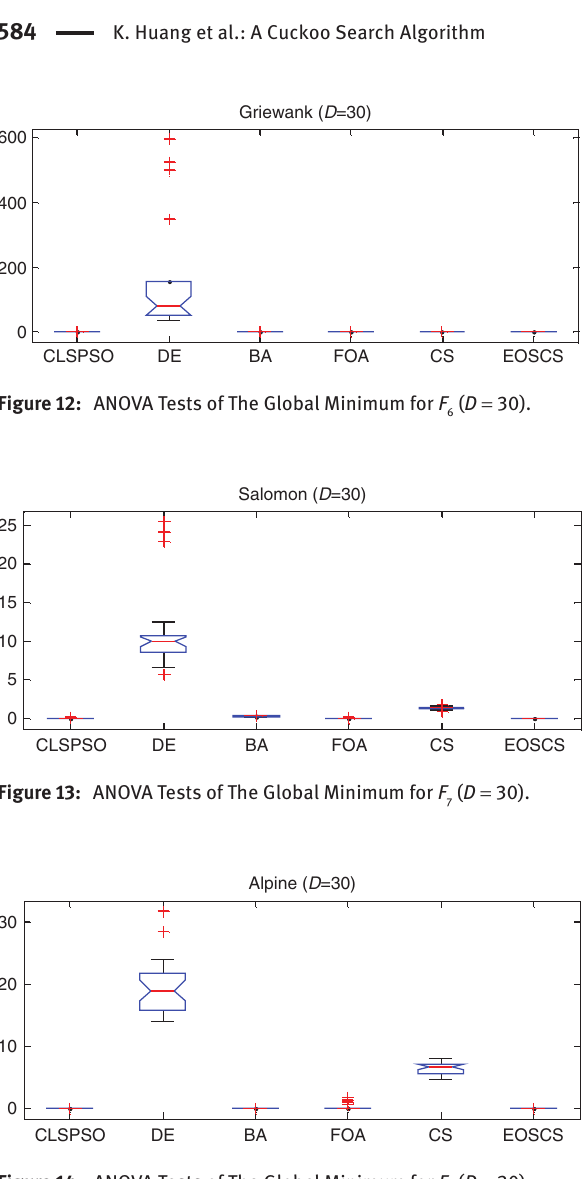
Figure 14: ANOVA Tests of The Global Minimum for F